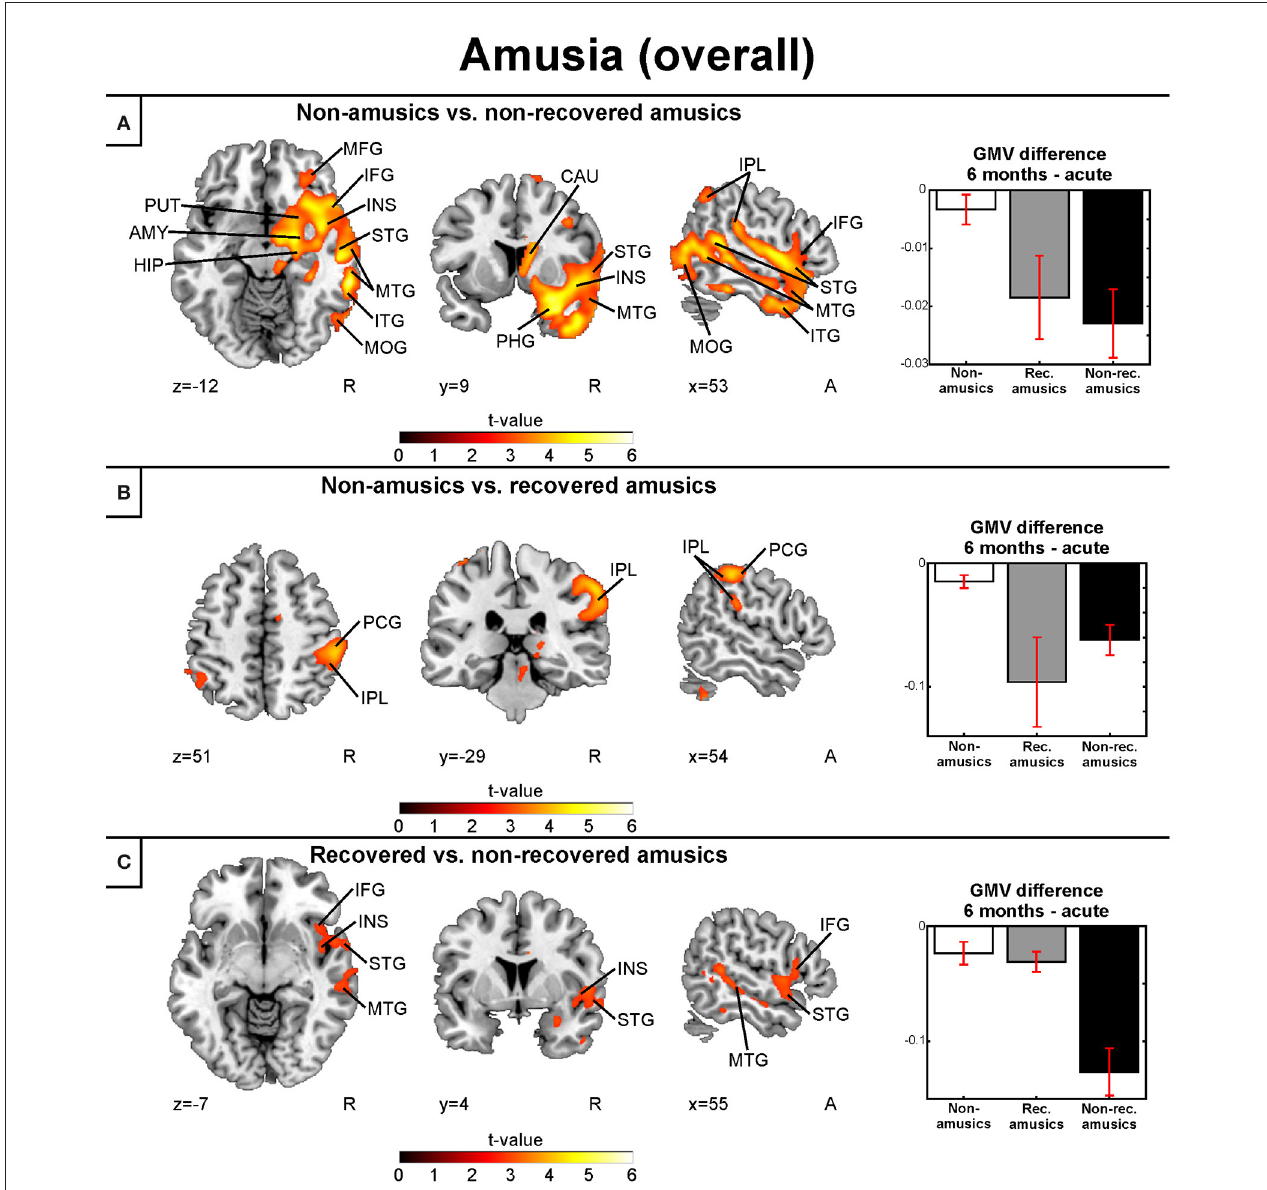
FIGURE 4 | Gray matter VBM results of pooled analysis: amusia. Time (6 months > Acute) × Group interactions for gray matter volume. (A) Non-amusic vs. non-recovered amusics; (B) Non-amusic vs. recovered amusics; (C) Recovered vs. non-recovered amusics. Results are thresholded at a whole-brain uncorrected p < 0.005 at the voxel level (extent threshold: k > 100 voxels) using MNI coordinates. Only clusters surviving an FWE-corrected p < 0.05 threshold are reported and labeled (see also Table 2 ). Bar plots for GMV differences in 6 months—Acute in significant clusters ( Table 2 ) are shown: bar = mean, error-bar = standard error of the mean. AMY, Amygdala; CAU, caudate; HIP, hippocampus; IFG, inferior frontal gyrus; INS, insula; IPL, inferior parietal lobule; ITG, inferior temporal gyrus; MFG, middle frontal gyrus; MOG, middle occipital gyrus; MTG, middle temporal gyrus; PCG, postcentral gyrus; PHG, parahippocampal gyrus; PUT, putamen; STG, superior temporal